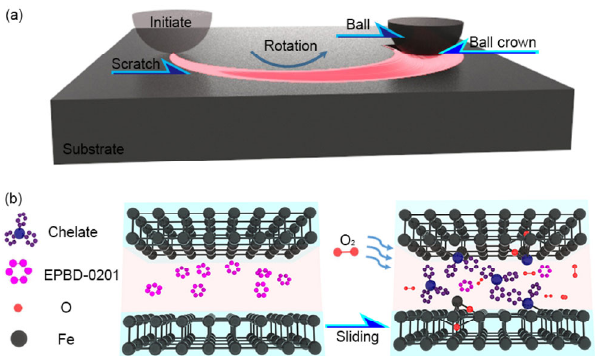
Fig. 10 Schematics showing the role of oxygen in the chelation reactions between the steel/steel sliding interface. (a) Oxidation wear causing reduction of contact stress. (b) Oxygen participates chelation reaction and improves the growth of chemisorption